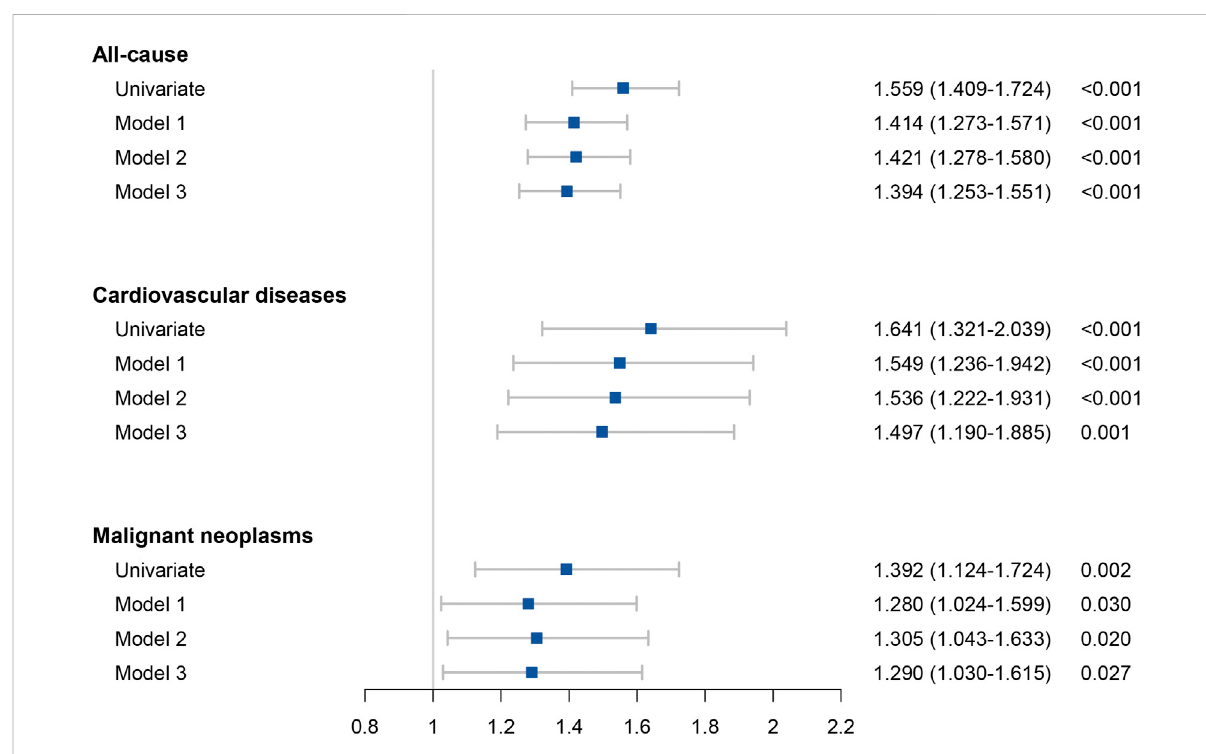
FIGURE 3 Forest plots of the results of all-cause mortality and cause speci fi c mortality in Cox